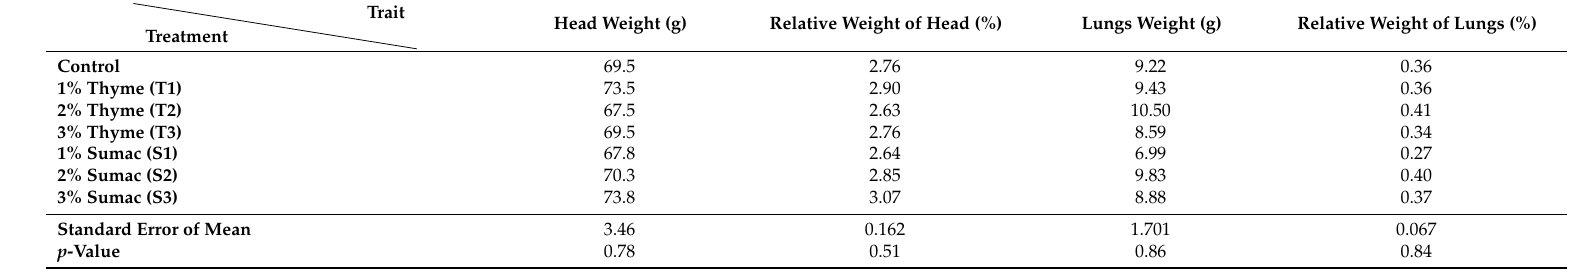
Table A2. Mean ( ± SEM) of less valuable body parts at 42nd days of age in Ross 308 broilers fed diets containing 0, 1, 2 and 3% Thyme (T3) and sumac from days 29-42.